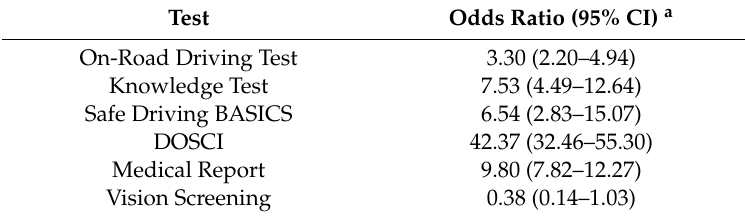
Table 3. Odds ratio of failing tests for those with dementia compared to those without dementia.